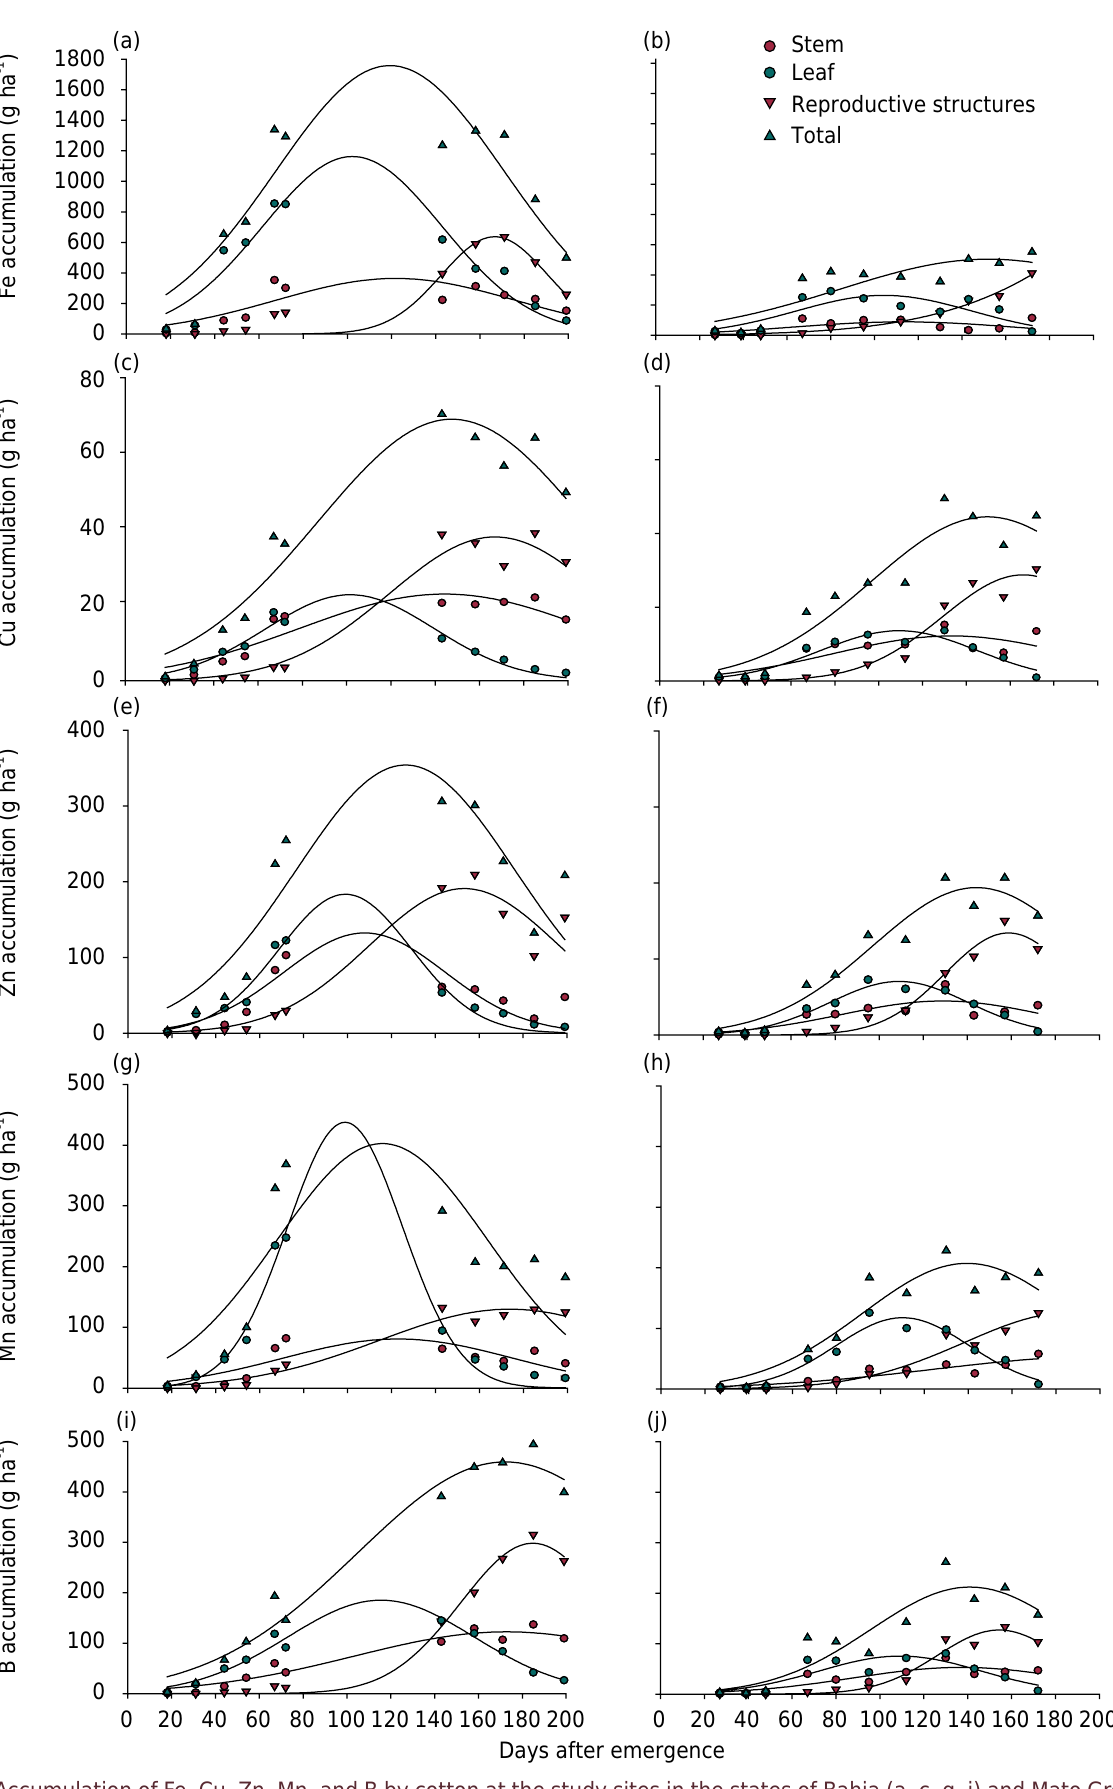
Figure 5. Accumulation of Fe, Cu, Zn, Mn, and B by cotton at the study sites in the states of Bahia (a, c, g, i) and Mato Grosso (b, d, f, h, j), Brazil. Results represent the average of three varieties in Bahia and two varieties in Mato